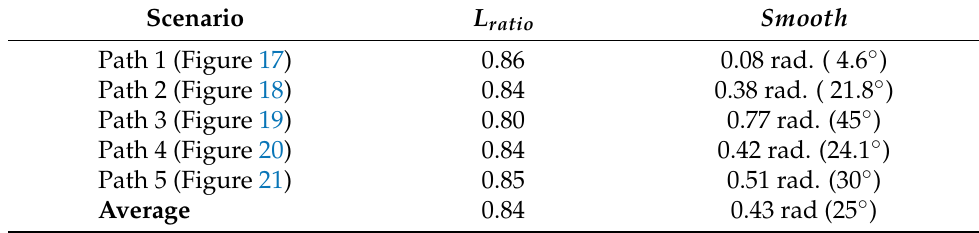
Table 2. L ratio and Smooth